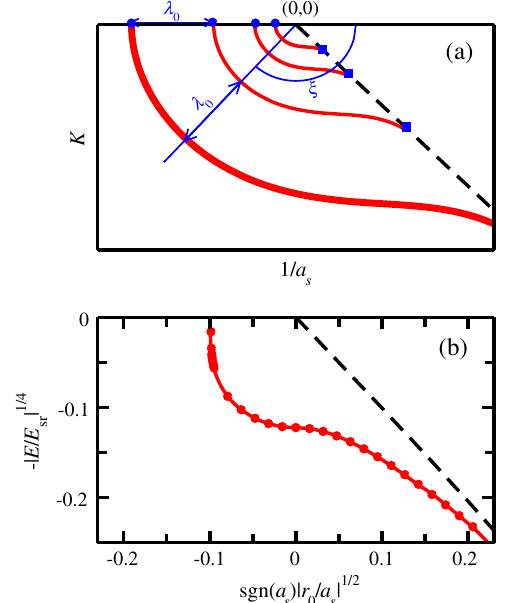
FIG. 1. Radial scaling law for the standard Efimov scenario. (a) The solid lines show the quantity K as a function of 1 =a for s the zero-range three-boson Hamiltonian. To make this plot, λ 0 has been artificially set to 2 instead of 22.694. The dashed line shows the atom-dimer threshold. The thin radially outgoing solid lines and arrows illustrate the scaling law. Circles and squares mark the critical scattering lengths a − at which the trimer energy is degenerate with the three-atom threshold and the critical scatter- ing lengths a (cid:3) at which the trimer energy is degenerate with the atom-dimer threshold, respectively. (b) Collapse of neighboring ˆ H energy levels for the finite-range interaction model [ in rel Eq. (5) with V 2 and V 3 replaced by V 2 and V 3 , b ; zr b ; zr b ; G b ; G respectively; R 0 ¼ shows the fourth root of the energy of the lowest three-boson state as a function of the square root of the inverse of the s -wave scattering length. The dashed line shows the associated atom- dimer threshold. The dots show the energy of the second-lowest three-boson state, with the radial scaling law applied in reverse so as to collapse the second-lowest level (dots) onto the lowest level (solid line). For clarity, the scaled atom-dimer threshold for the second-lowest three-boson state is not